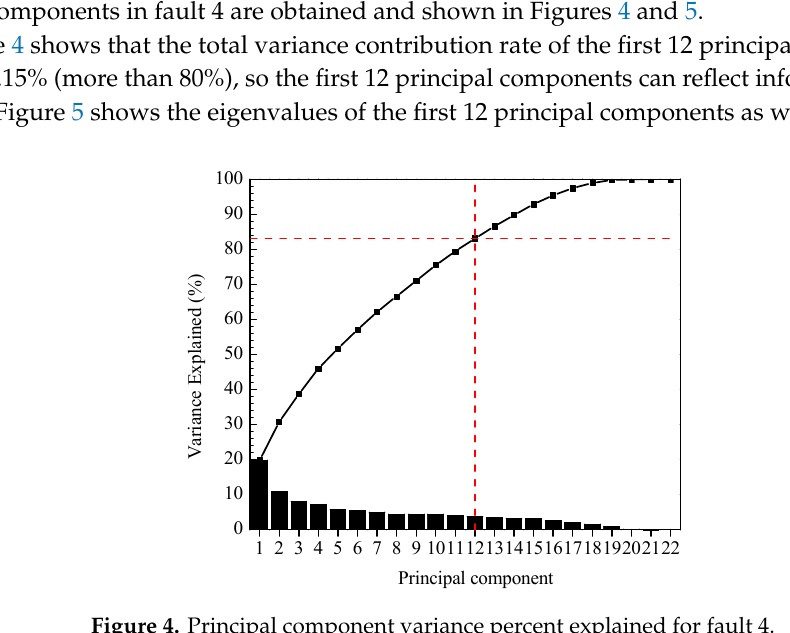
Table 3. Preset faults of the TE process.